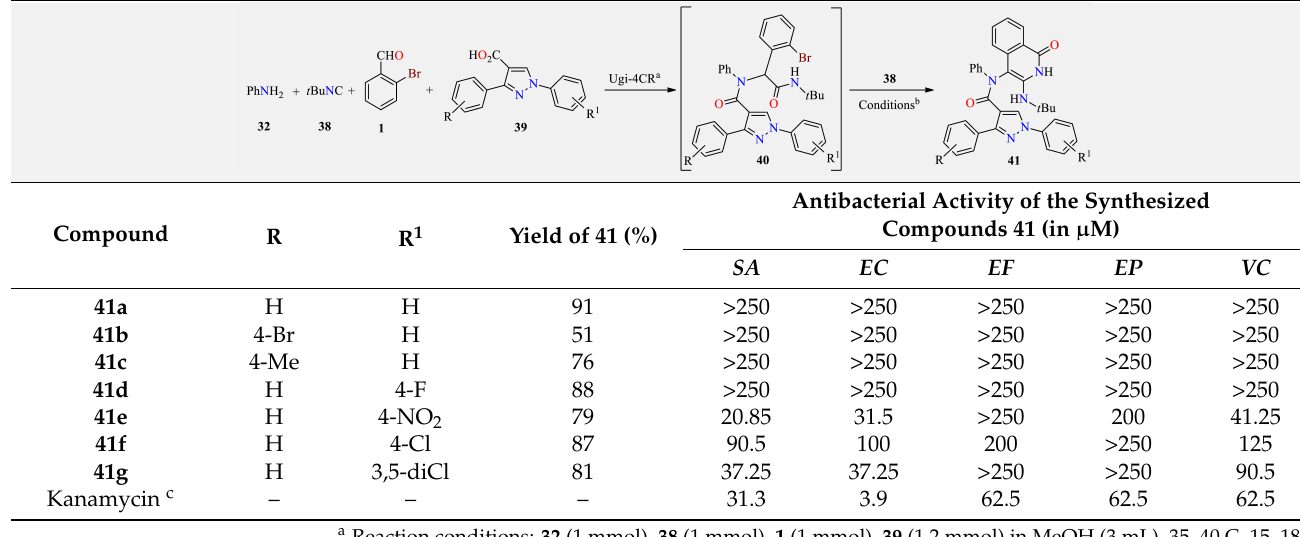
Table 9. Schematic route for the multicomponent synthesis of pyrazole-based Ugi products 41 and their in vitro antibacterial activities (MIC) against five bacterial